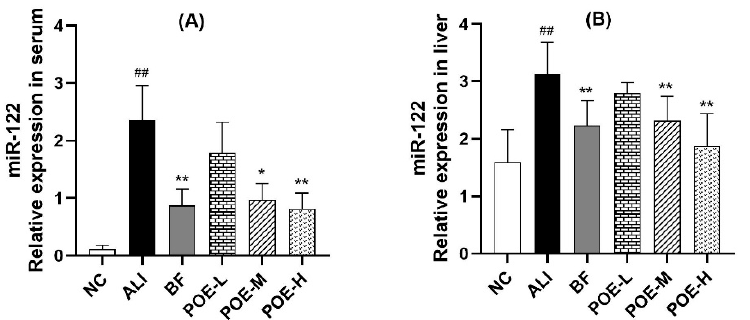
Figure 4. Effects of POE on expression of miR-122 in serum and liver of rats with alcoholic liver injury. ( A ) miR-122 in serum, ( B ) miR-122 in liver. Values are presented as Mean ± SEM, n = 6. ## p < 0.01 compared with NC group. * p < 0.05 and ** p < 0.01 compared with ALI group.